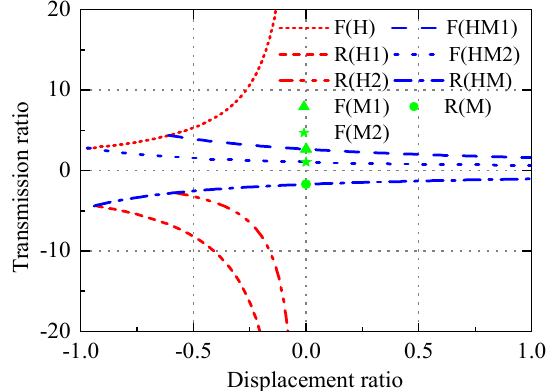
Figure 2. HMT speed regulation characteristic curve.